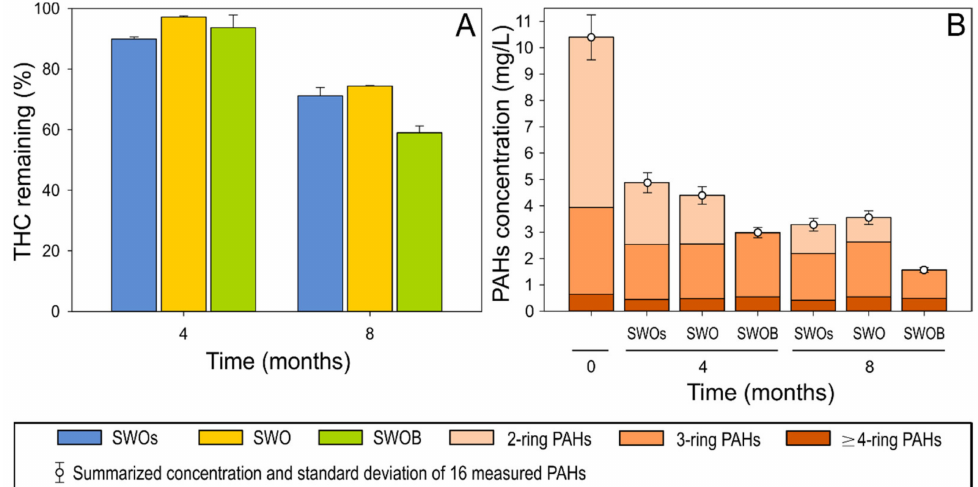
Figure 1. The proportion of total hydrocarbons (THC) remaining ( A ) and the concentration of 16 priority PAHs ( B ) in the oil-amended sterilized seawater (SWOs), oil-contaminated seawater (SWO), and biostimulated oil-contaminated seawater (SWOB) at 4 and 8 months. N = 2.